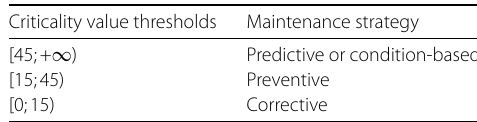
Table 2 Criticality value thresholds definition